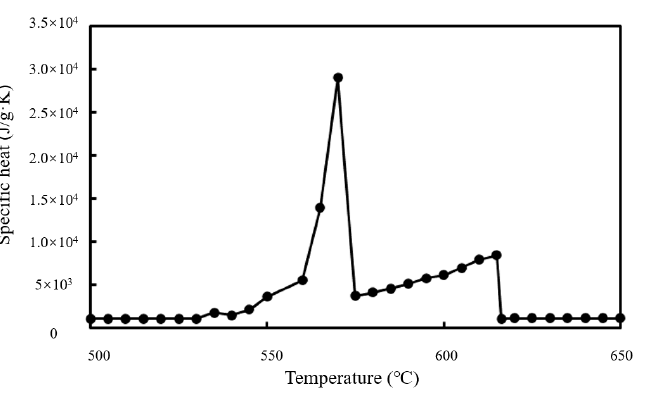
Figure 3. Specific heat–temperature relationship diagram of Al–Si–Mg alloy.